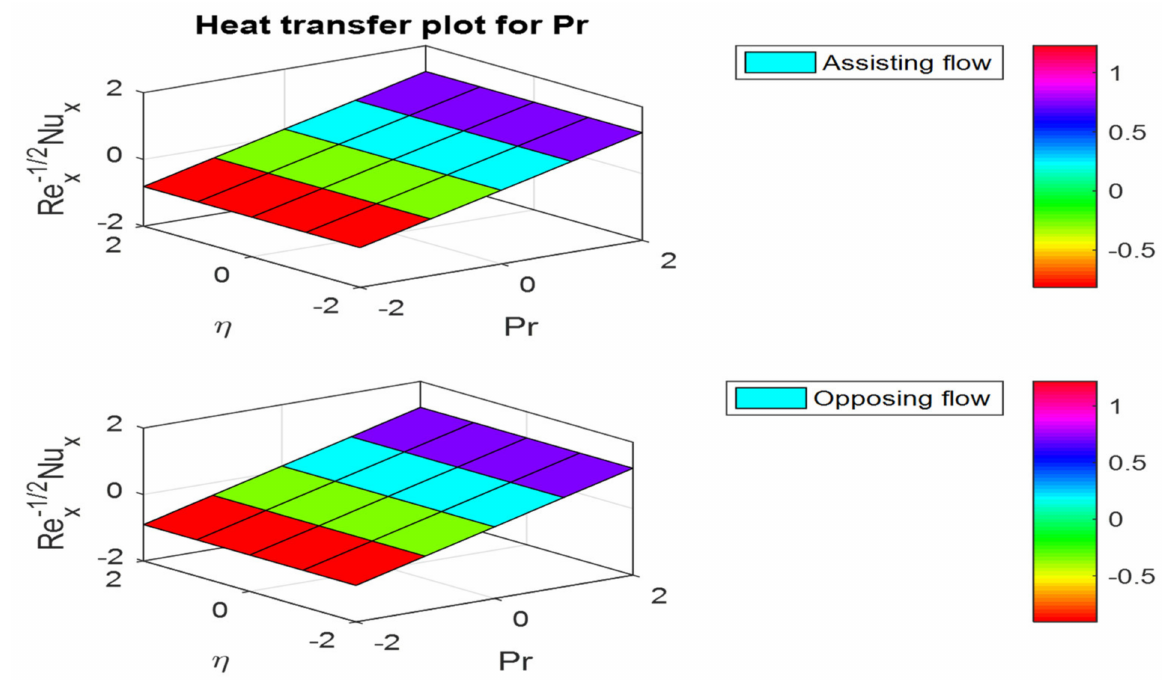
Figure 29. Surface plots for the θ (cid:48) ( 0 ) for dissimilar values of